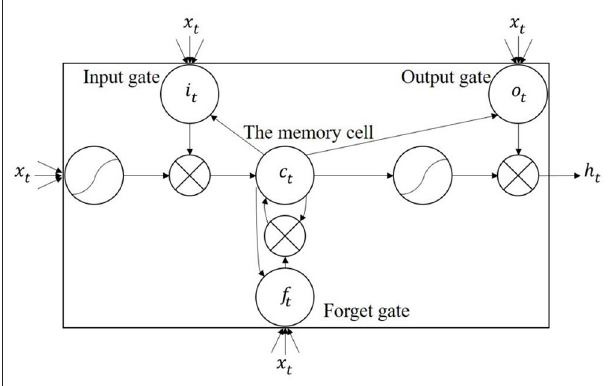
FIGURE 5 | The memory cell of LSTM.